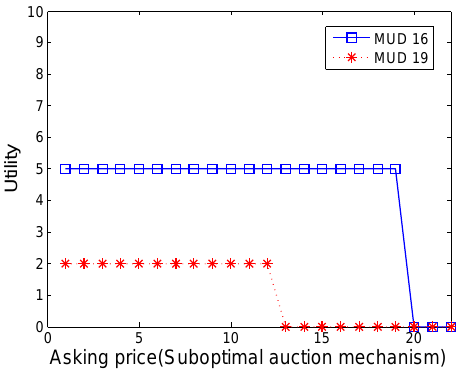
Figure 7. The utility of MUD 16 and MUD 19 by suboptimal auction mechanism in discontinuous